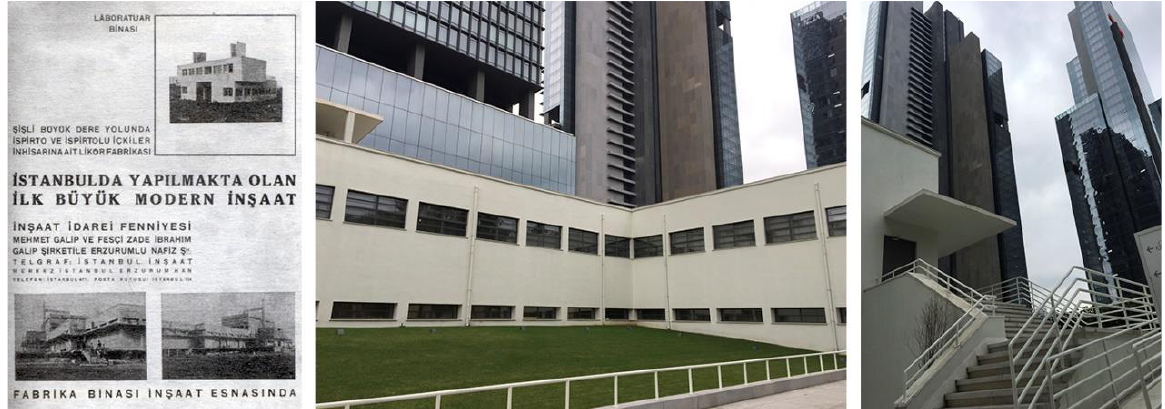
Figure 7 Mecidiyeköy Liqueur and Cognac Factory in 1931 and the rebuilt building as an art gallery in the front with Fairmont Quasar Istanbul (Photograph credits: Url-3 and personal archive of Feride Gül Keleş, 2019)